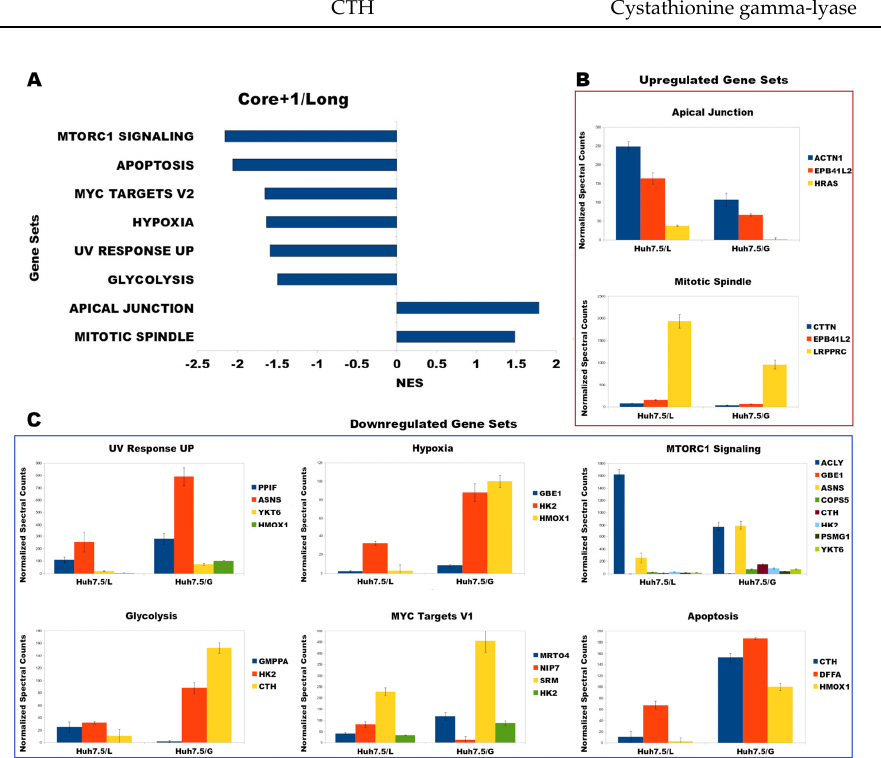
Figure 4. ( A ) GSEA of the 144 DEPs identified hallmarks in sample L (FDR ≤ 0.27, and nominal p< 0.05). ( B ) Upregulated enriched sets and the normalized protein levels found in sample. ( C ) Downregulated enriched sets and the normalized protein levels found in sample L. GSEA, gene set enrichment analysis. NES, normalized enrichment score. FDR, false discovery rate.